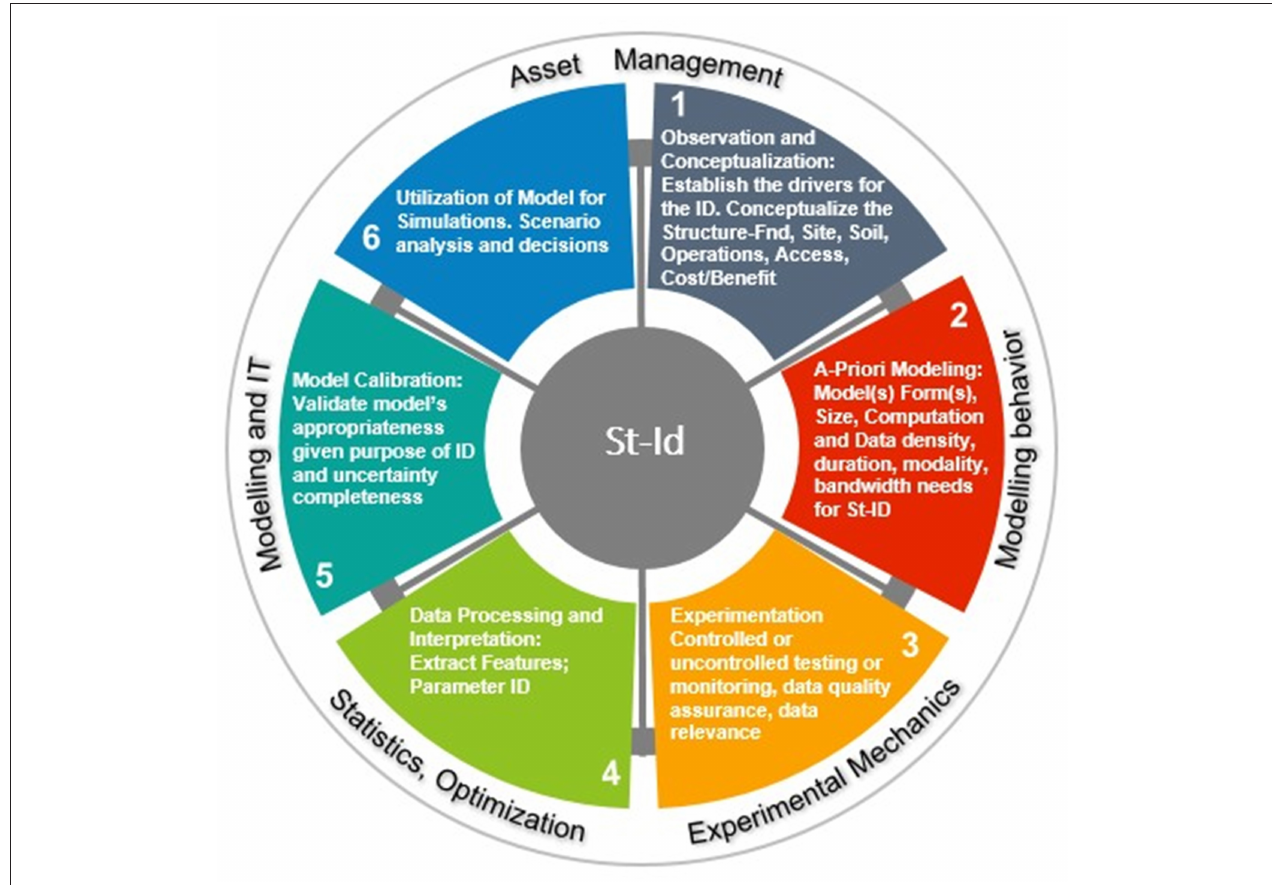
FIGURE 4 | Steps of structural systems